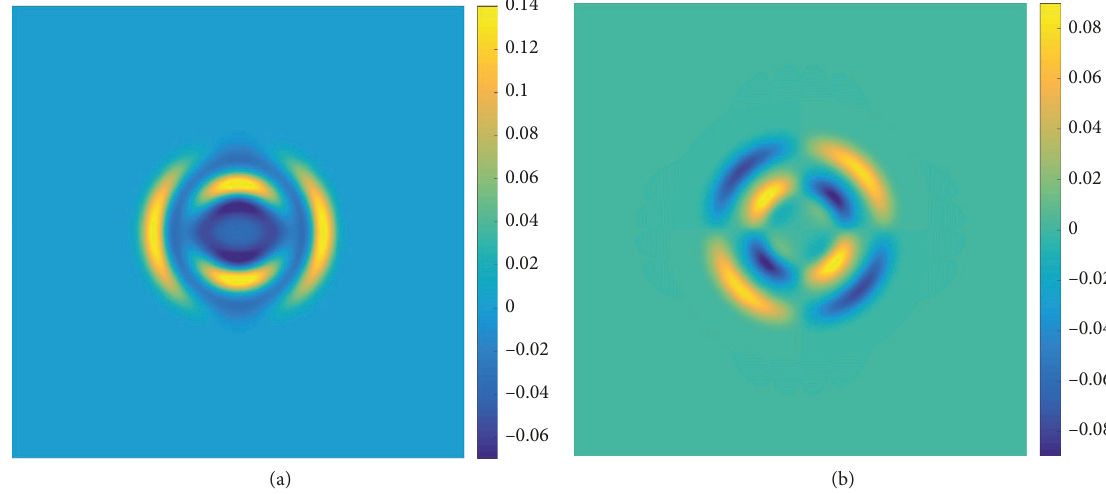
Figure 4: Velocity distribution in x and z directions at time � 0.3s. (a) x direction (b) y direction.